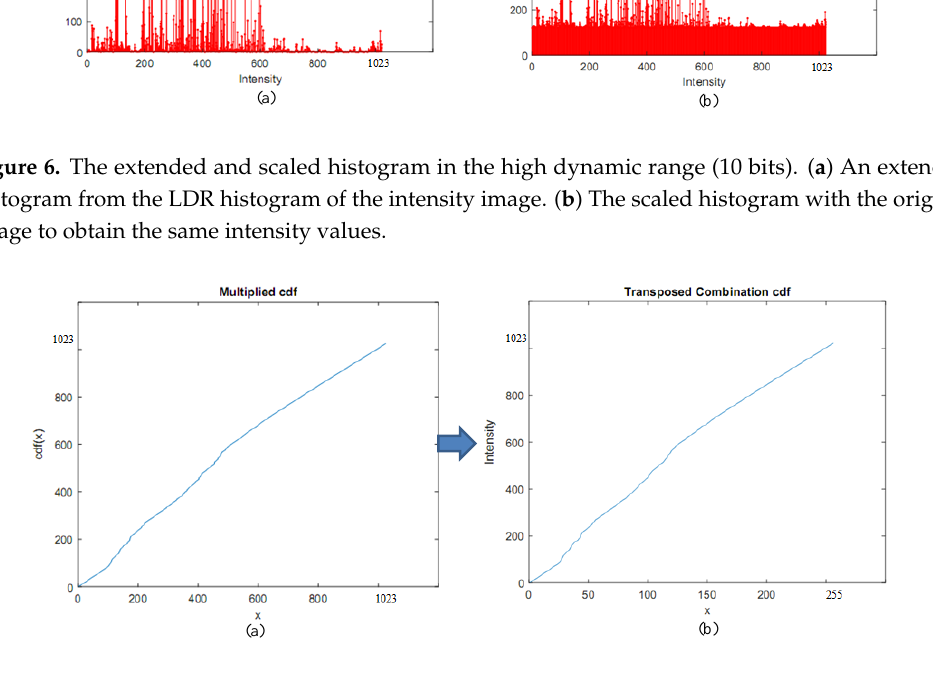
Figure 7. The multiplied cumulative probability of the extended histogram and transposed combination CDF of the extended histogram. ( a ) Multiplied cdf. ( b ) Transposed Combination